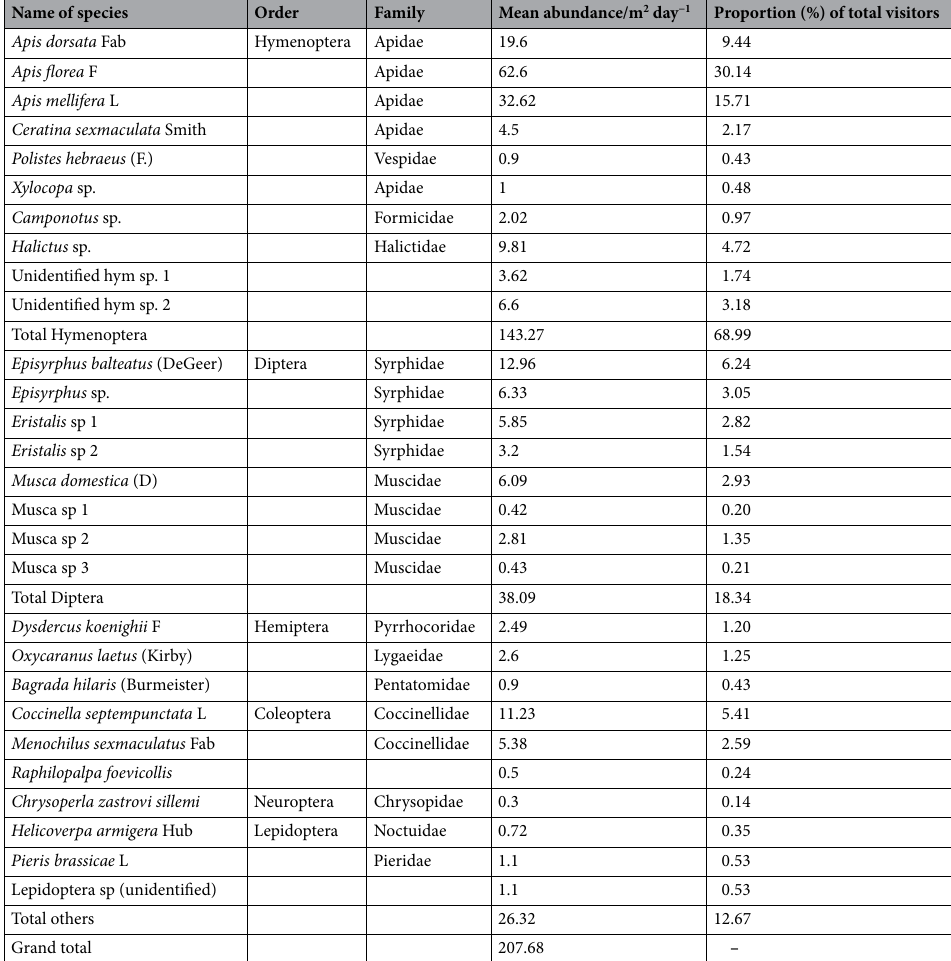
Table 2. Diversity of floral visitors on dill ( Anethum graveolens L.) during rabi in semi-arid region. The data given in table are the pooled data of 2 years research (2016–2017 &